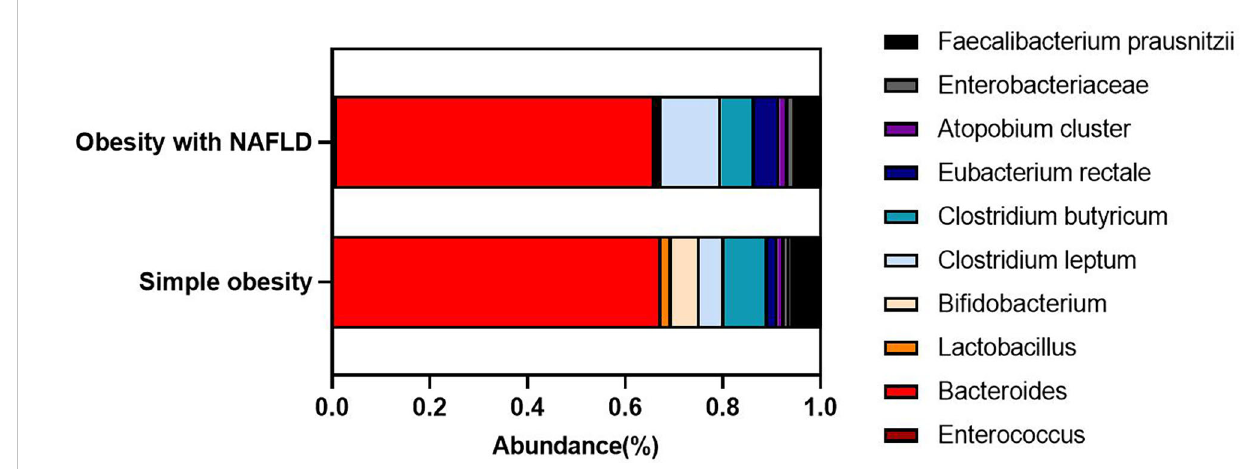
FIGURE 3 Stacked Bar chart of the dominant gut microbiota in obesity with NAFLD and simple